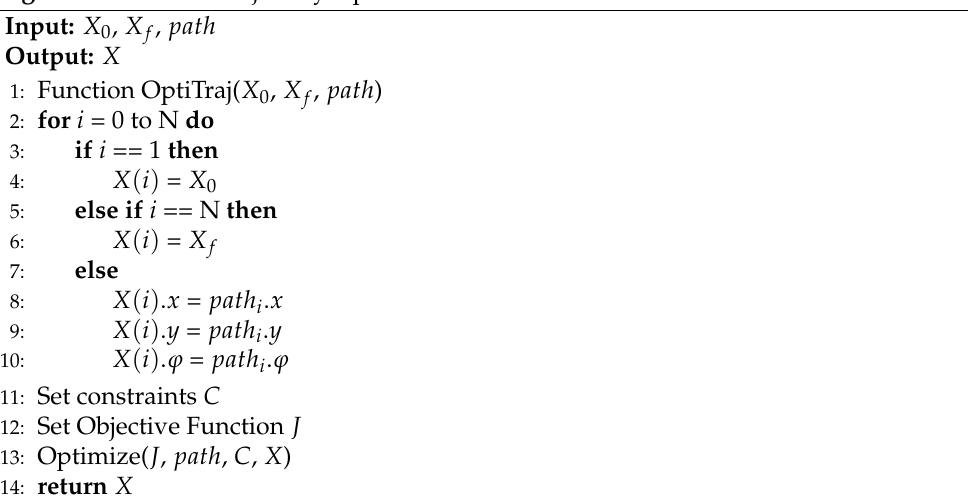
Algorithm 2 Global Trajectory